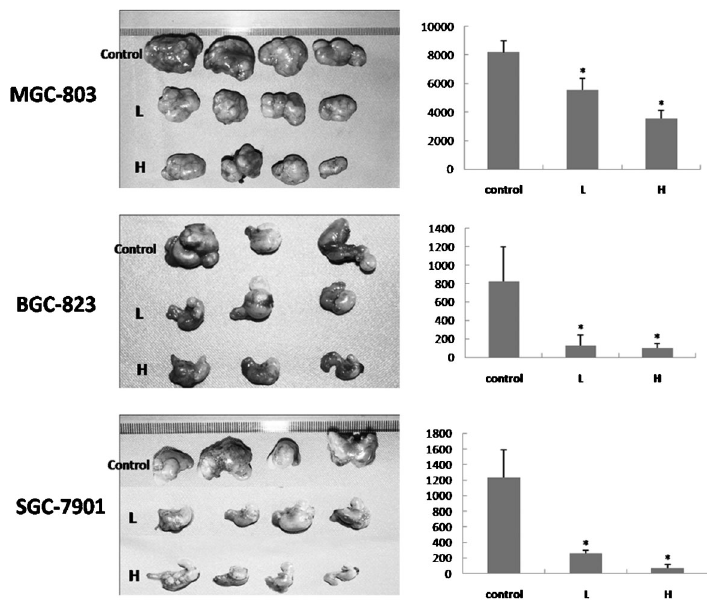
Figure 3. Effect of S-adenosylmethionine (SAM) treatment on tumor growth in nude mice. There was a significant reduction in tumor volume (in mm 3 ) between SAM treatment group (L: 192 m mol ? kg -1 ? day -1 SAM, H: 768 m mol ? kg -1 ? day -1 SAM) and control in MGC-803, SGC-7901, and BGC-823. *P , 0.05, compared to